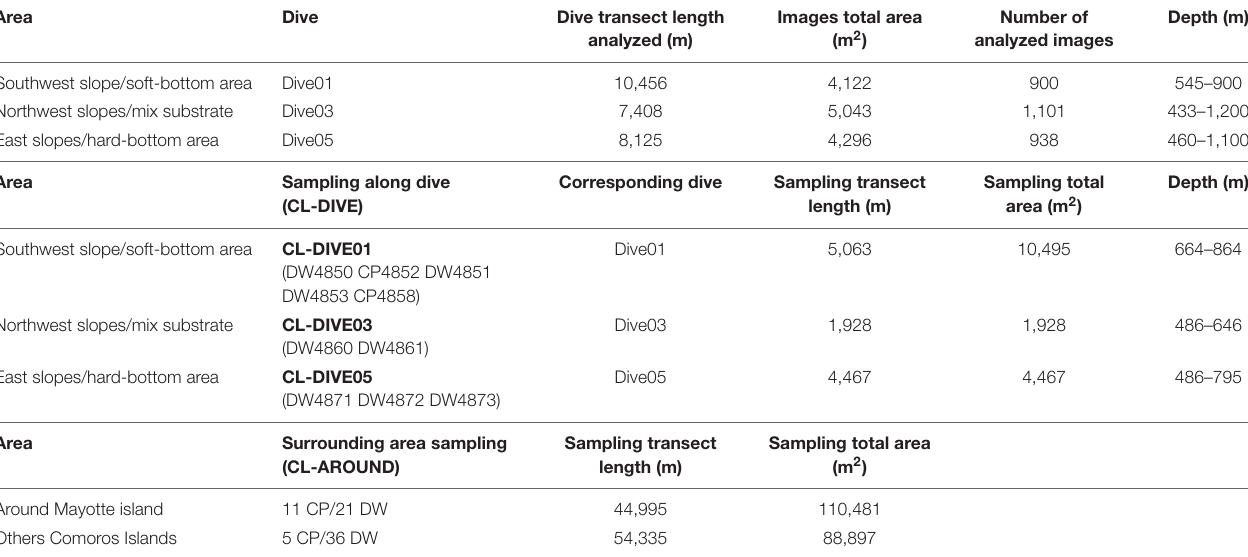
TABLE 2 | Summary of image acquisition and physical sampling efforts with sites information for the dive, sampling along dive (cl-dive) and in the surrounding area (cl-around) along volcanic island slopes of